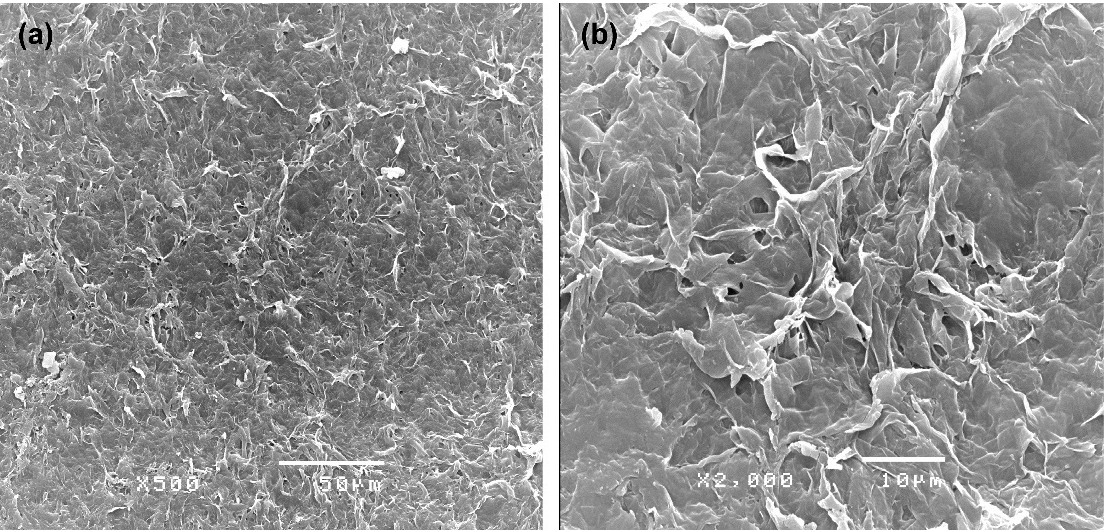
Figure 5. Scanning electron micrographs of the surface of the PHBV film extracted from Cyanosarcina sp. AARL T020 at different magnifications: ( a ) 500 × and ( b ) 2000 × .